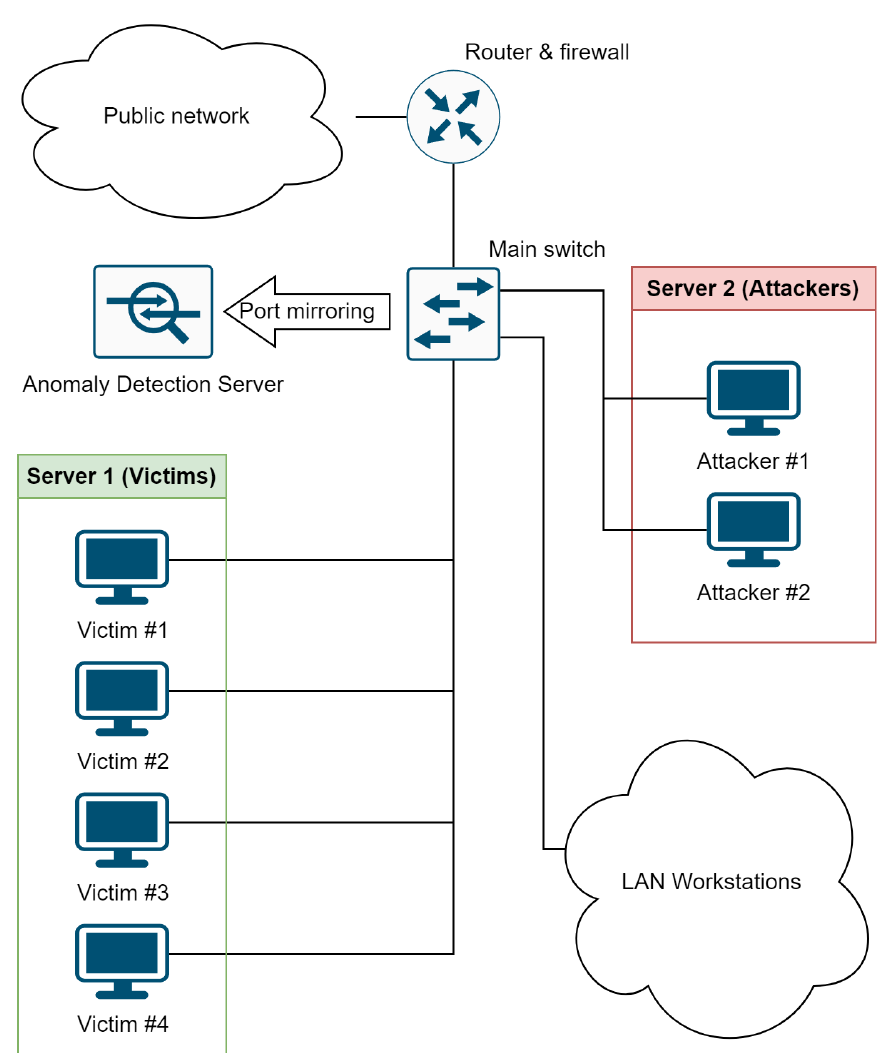
Figure 1. Network architecture scheme showing the placement of the anomaly detection server on the background of the inner infrastructure, including LAN workstations, servers with virtual attackers and